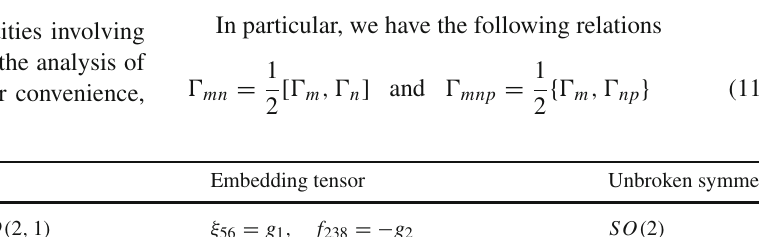
Table 1 Examples of